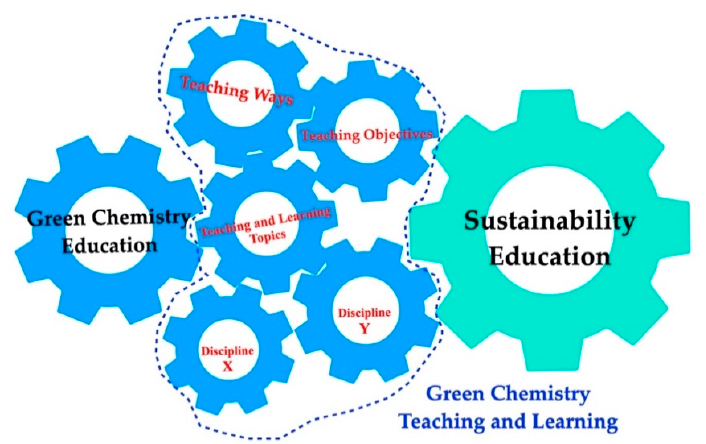
Figure 1. Schematic role of green chemistry teaching and learning in promoting sustainability education.